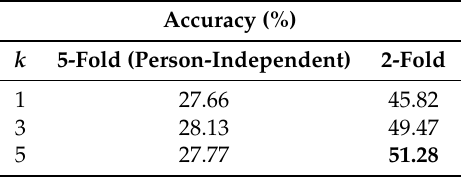
Table 5. Emotion detection accuracy achieved for different k of k -NN for MATLAB implementation.